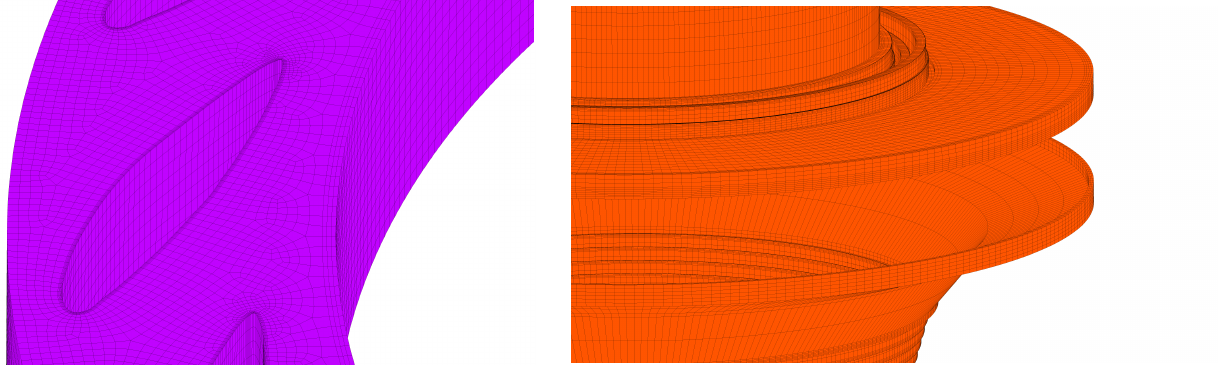
Figure 6. Meshes of the guide vane domain ( left ) and the upper and lower labyrinth seals ( right ).